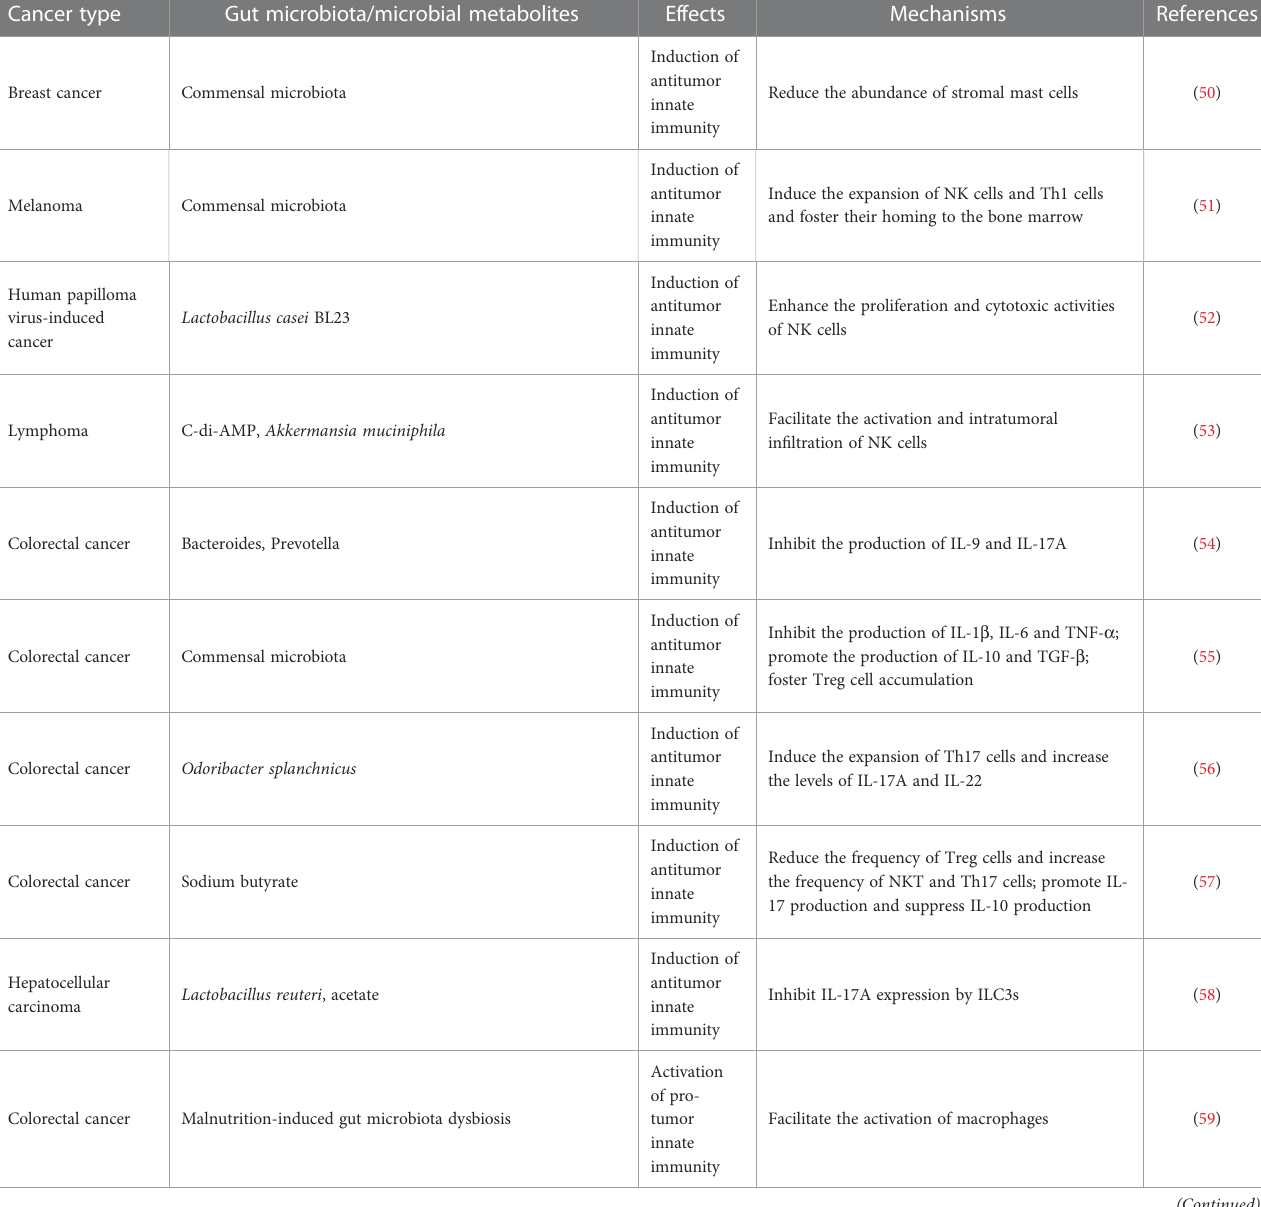
TABLE 1 The regulatory effects of gut microbiota and its metabolites on tumor